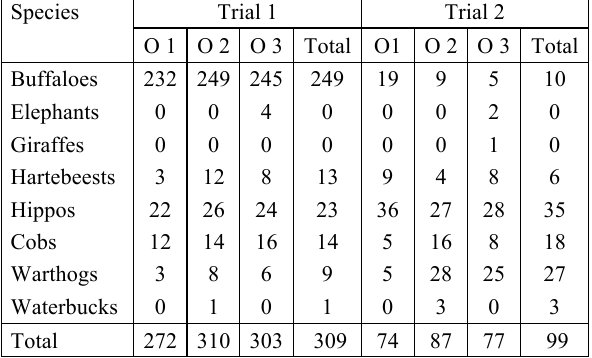
Table 8. Comparative results of the detection by species for each trial and total once the differences between observers have been verified and observations reallocated